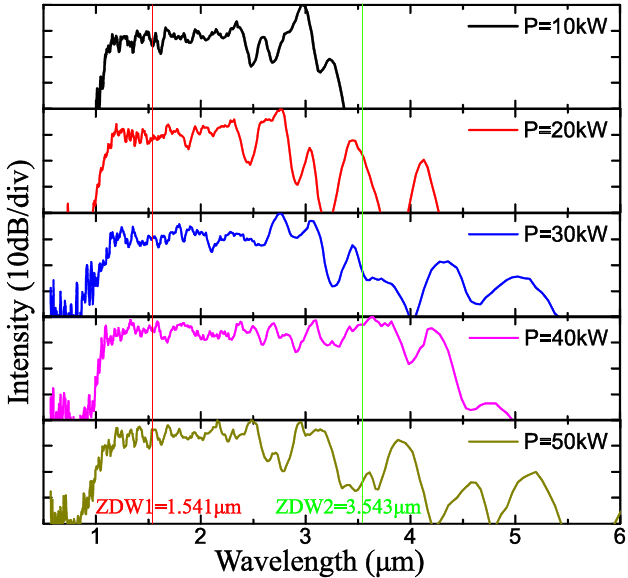
Figure 12. Simulated evolution of SCG pumped at 1.541 µm wavelength at different peak powers.